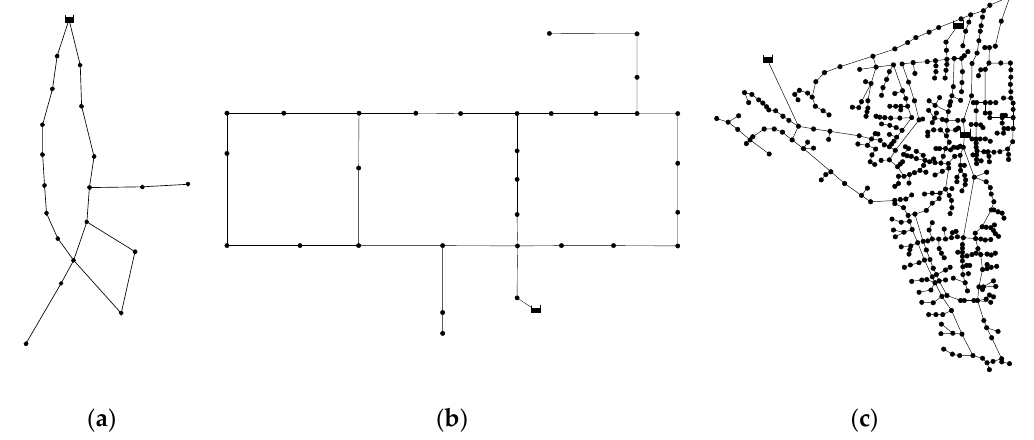
Figure 2. The layout of each benchmark network. ( a ) NYT; ( b ) HAN; ( c ) BIN.